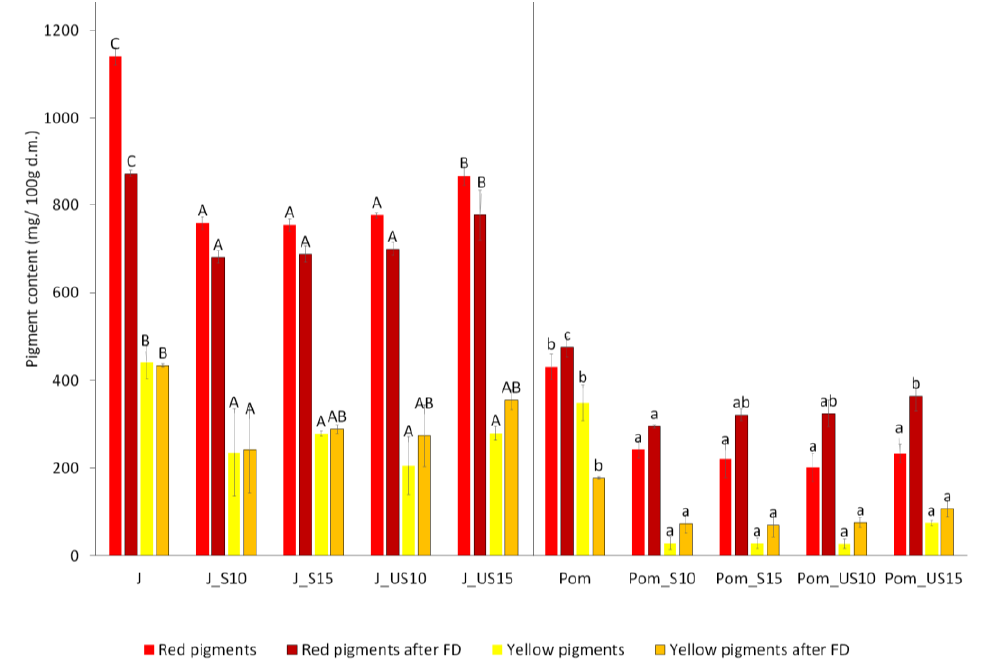
Figure 1. Pigments content. Sample abbreviation: J-Juice, Pom – Pomace, S-Steam, US – Ultrasound, 10, 15 – time of pretreatment (min); A – D different capital letters in the each series for juices means statistical difference, a – d different small letters in each series for pomace means statistical difference